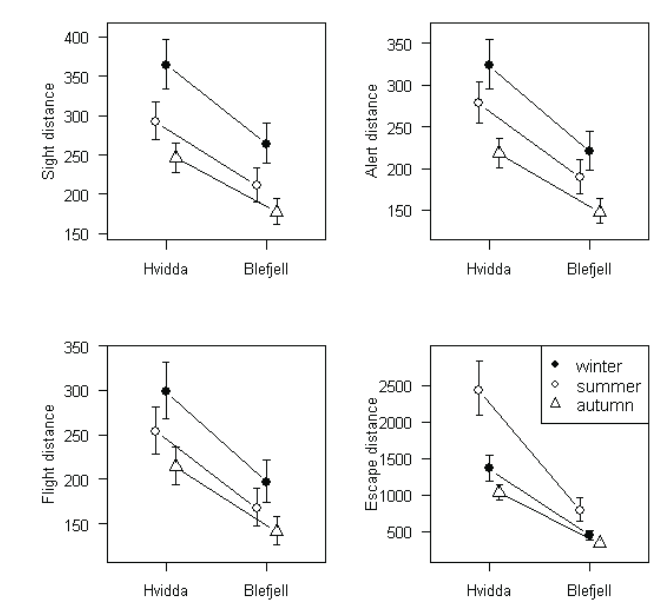
Fig. 2. Predicted values (m) of a) sight distance, b) alert distance, c) flight initiation distance and c) escape distance of reindeer groups disturbed by an intruding person in Hardangervidda and Blefjell, south central Norway. Reference levels of categorical variables (if included in the model; see Tables 2-5) are rugged terrain and mixed group structure. For the numerical variable encounter distance the predictions are based on the mean. Error bars are 1